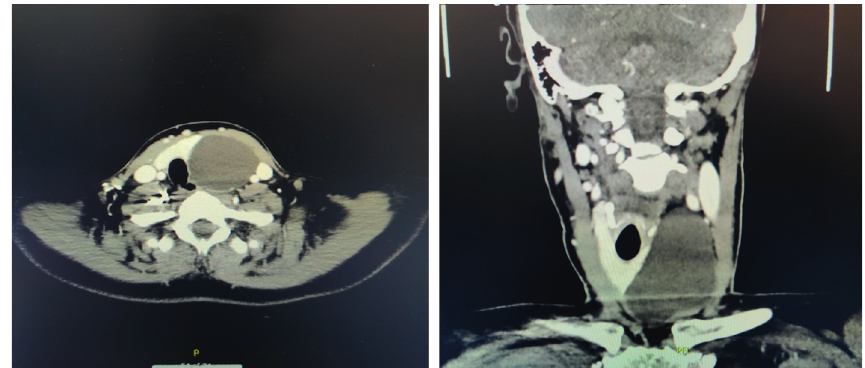
Figure 1: CTneck demonstrating left thyroid cystic mass measuring 7.9 × 5.7 × 5.7 cm displacing left internal jugular vein and left common carotid laterally.